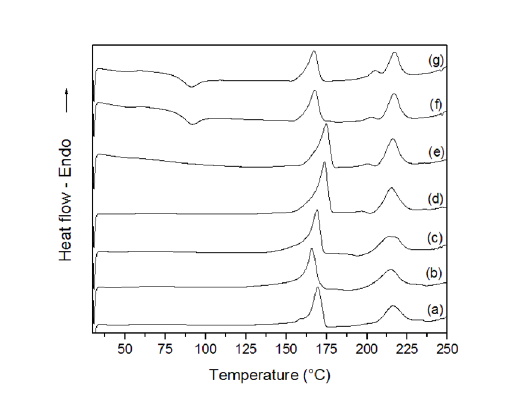
Figure 9. DSC heating curves of scPLA/GNPO+ nanocomposite after isothermal crystallization at: (a) 105ºC, (b) 120ºC, (c) 135ºC, (d) 150ºC, (e) 155ºC, (f) 160ºC and (g)